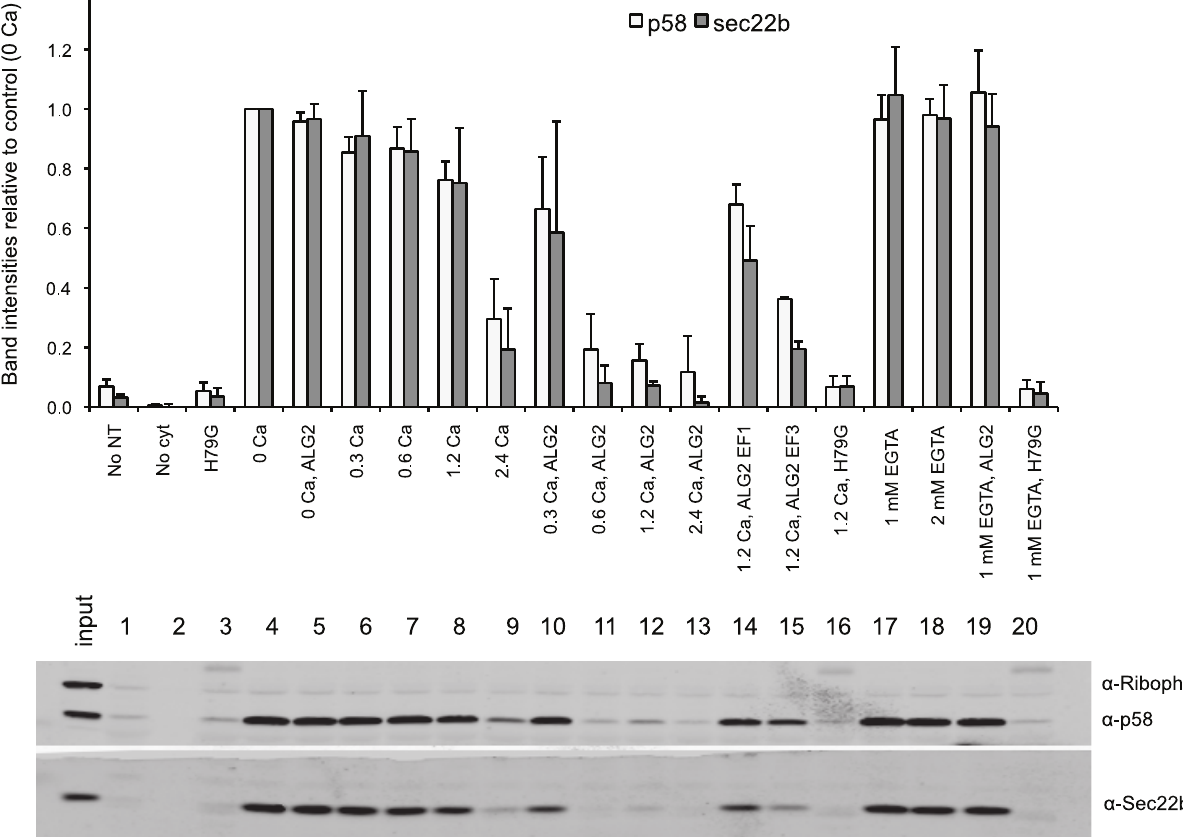
Figure 1. ALG-2 attenuates COPII dependent budding. The budding efficiency was measured from the amount of p58 and Sec22b in vesicles relative to the amount in donor membranes. HeLa cell donor membranes were incubated with rat liver cytosol, ATP and an ATP regenerating system, and wild-type recombinant ALG-2 (lanes 10–13) or ALG-2 with mutant versions of either EF-hand 1 (ALG2EF1, lane 14) or EF-hand 3 (ALG2EF3, lane 15) in the presence of either Ca 2 + (lanes 6–16) or chelator (EGTA, lanes 17–20). As controls, membranes were incubated in the absence of either nucleotides (No NT, lane 1) or cytosol (No cyt, lane 2). As a control for the requirement of COPII proteins, we performed assays in the presence of a GTP-restricted dominant-negative form of the GTPase Sar1, Sar1 (H79G, lanes 3, 16 and 20). Budding efficiency was measured from band intensities and normalized to the amount of budding in the no Ca 2 + , no ALG-2 vesicle budding (0 Ca, lane 4) reaction. Bars indicate average + / 2 SD of three independent